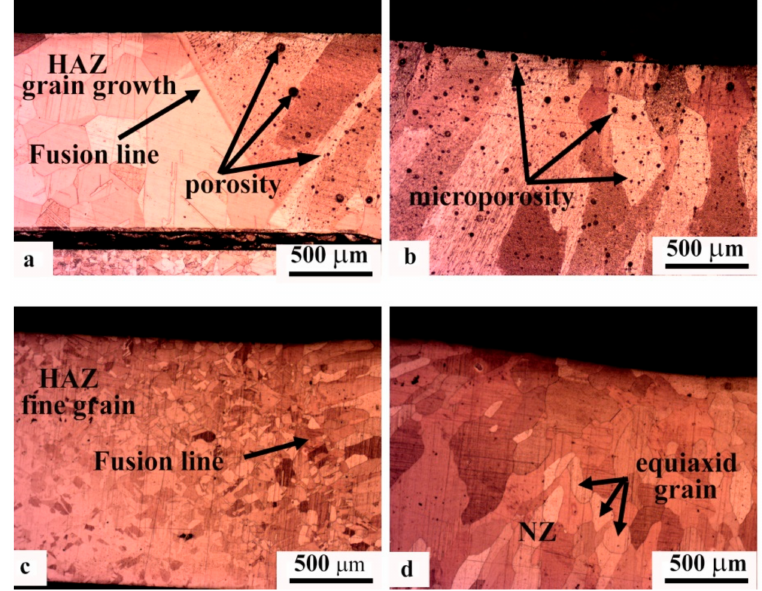
Figure 7. The cross-section microstructure of GTA spot-welded joints. ( a , b ) Locations labeled in Figure 4a for joints welded without USV; and ( c , d ) the locations labeled in Figure 4b for joints welded with USV